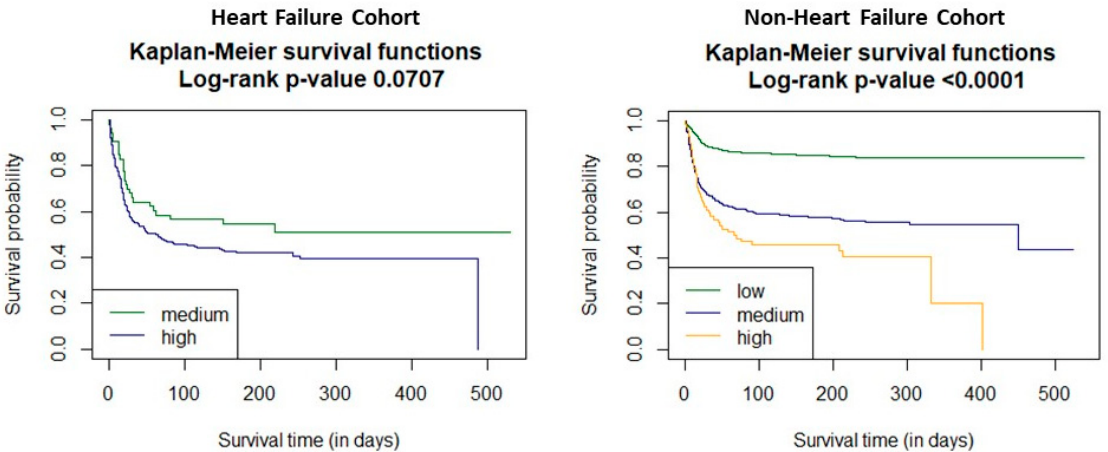
Figure 4. The survival curves for the C 2 HEST strata in both study cohorts, estimated by Kaplan– Meier function. Table 5. The total all-cause death hazard ratios for C 2 HEST risk stratification in the heart failure cohort.